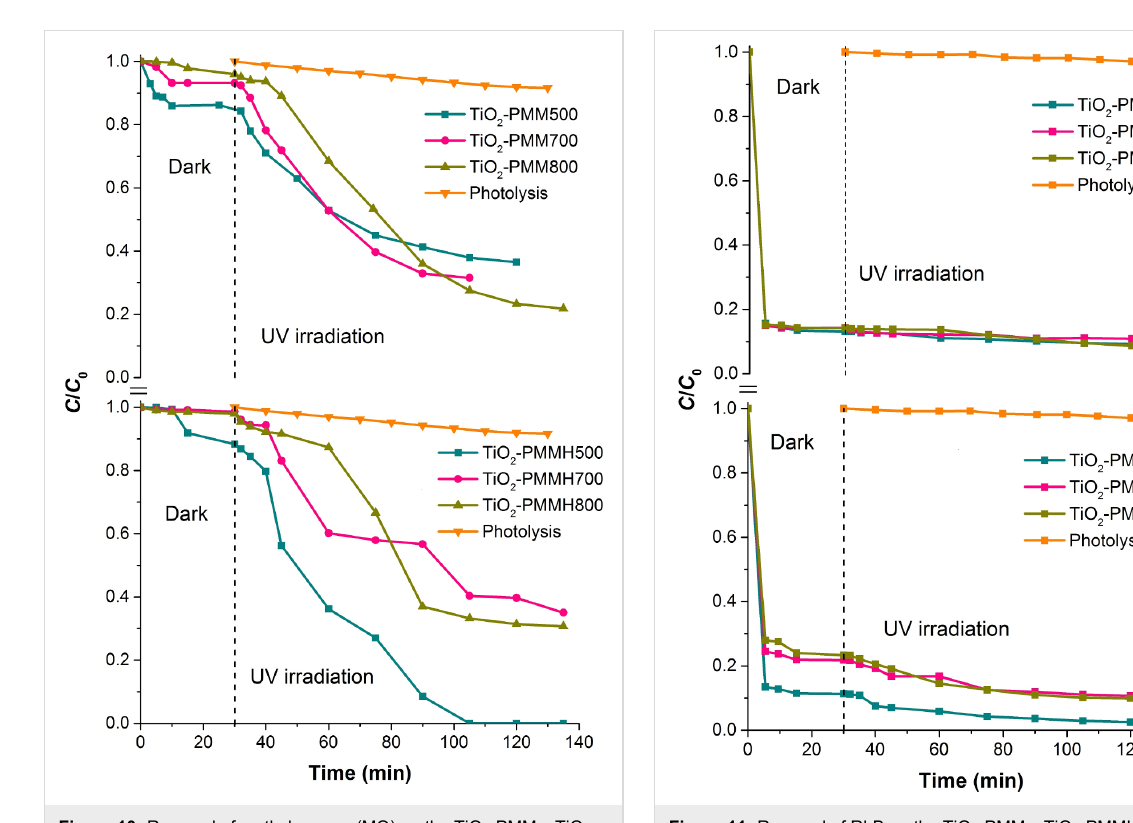
Figure 10: Removal of methyl orange (MO) on the TiO 2 -PMM x , TiO 2 - PMM Н x samples used as photocatalysts and that without photocata- lyst in the dark and under UV irradiation.